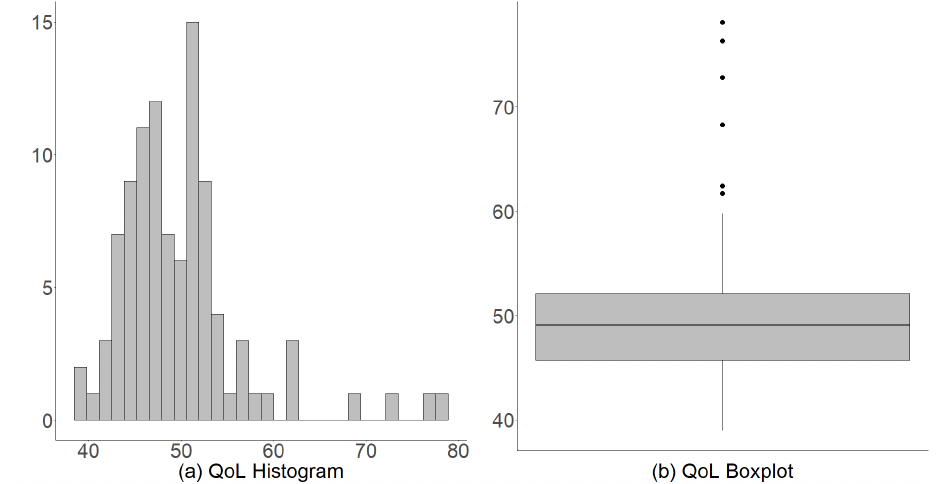
Figure 3. ( a ) Distribution histogram for quality of life 2021. ( b ) Boxplot for distribution of values of quality of life